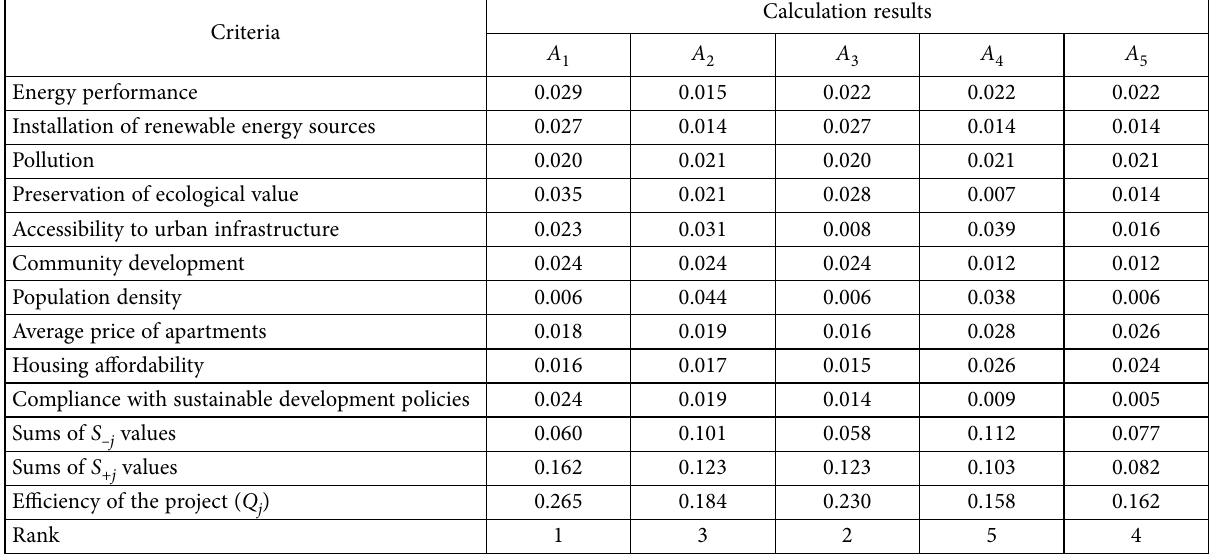
Table 4. Multiple criteria assessment results (COPRAS method)